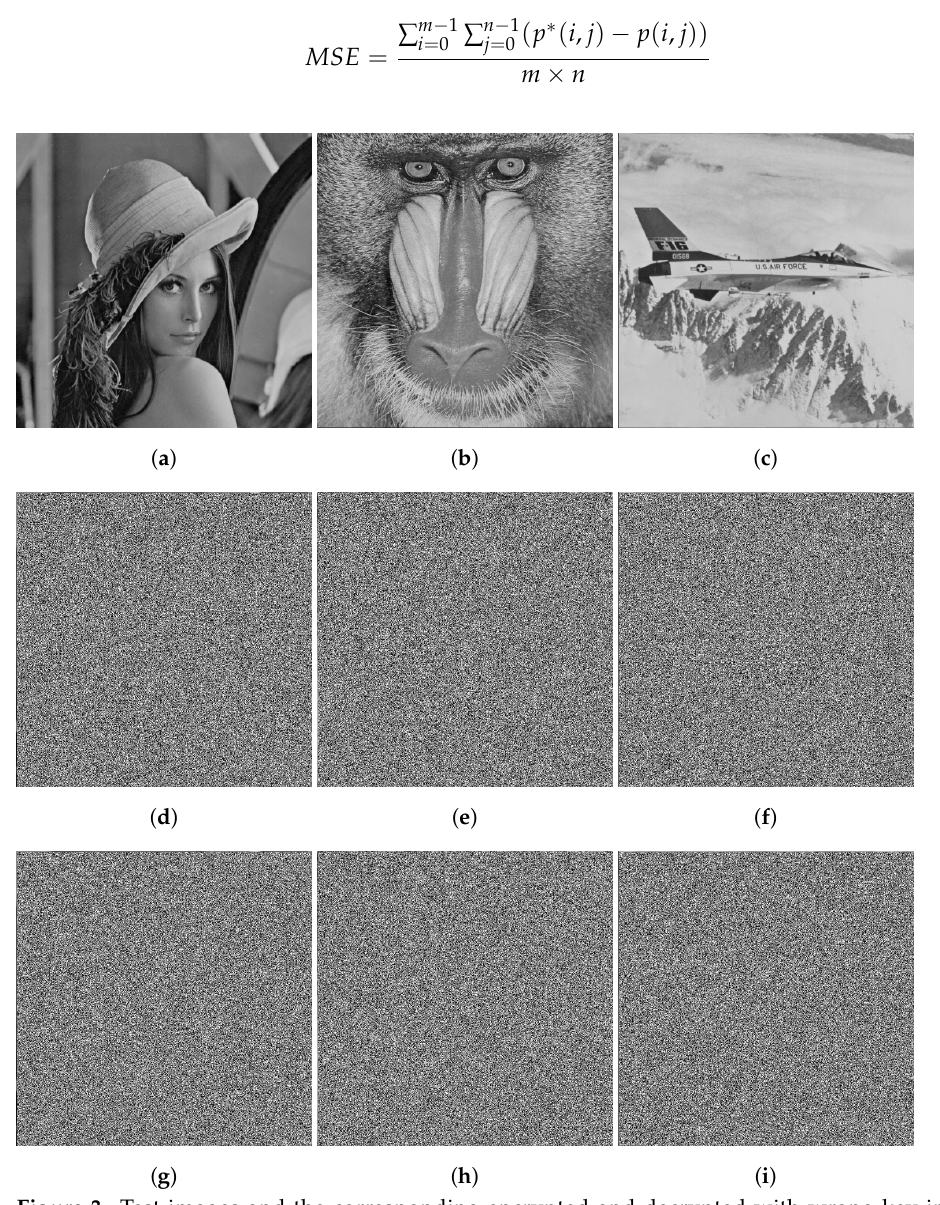
Figure 3. Test images and the corresponding encrypted and decrypted with wrong key images. ( a ) Lena. ( b ) Baboon. ( c ) Jetplane. ( d ) Encrypted result of ( a ). ( e ) Encrypted result of ( b ). ( f ) Encrypted result of ( c ). ( g ) Illegal decryption of ( d ). ( h ) Illegal decryption of ( e ). ( i ) Illegal decryption of ( f